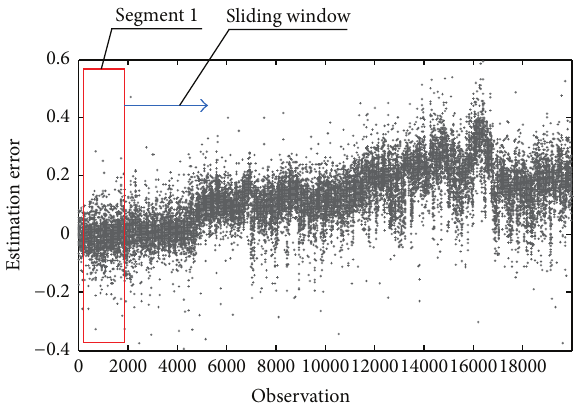
Figure 6: Estimation error with marked segment 1 (red) and sliding window